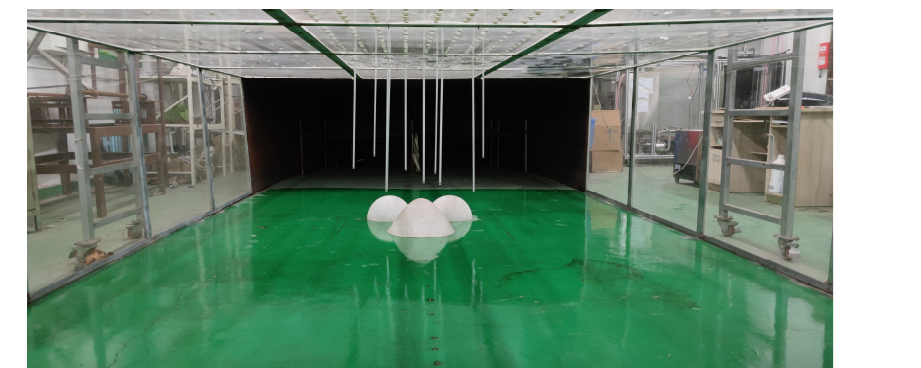
Figure 3. Wind tunnel experimental equipment.